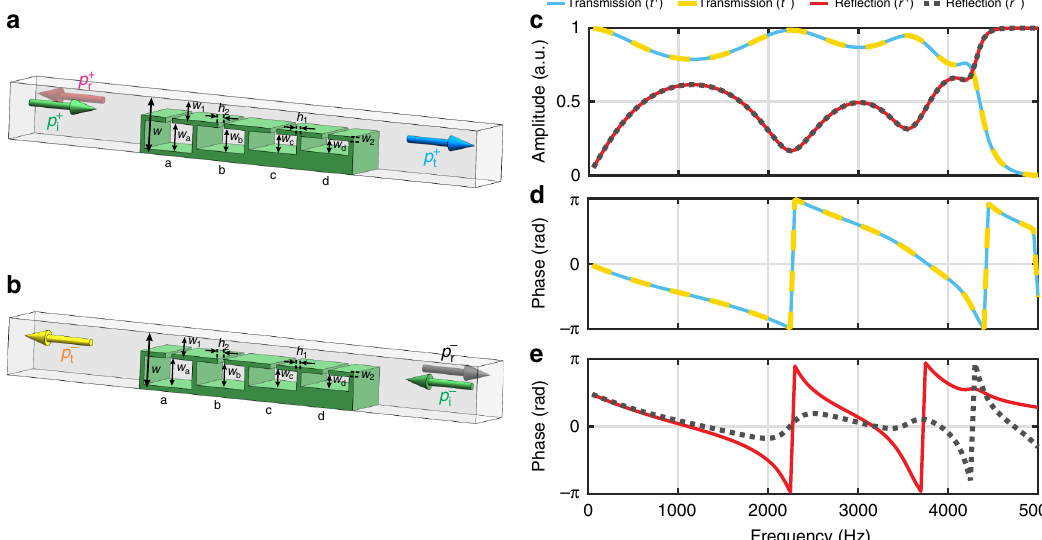
Fig. 2 Study of a bianisotropic acoustic cell. a Geometry of a cell with four side-loaded resonator. The height of the Helmholtz resonators is varied to create different bianisotropic responses. De fi nition of the forward ( + ) and backward ( − ) illuminations. b Amplitude and phase of the transmission and re fl ection coef fi cients of an arbitrary cell. The dimensions of the cell are: w = 12 mm, h 2 = 1.5 mm, w 2 = 1 mm, h 1 = 1 mm, w 1 = 4 mm, w a = 6 mm, w b = 5 mm, w c = 4 mm, and w d = 3